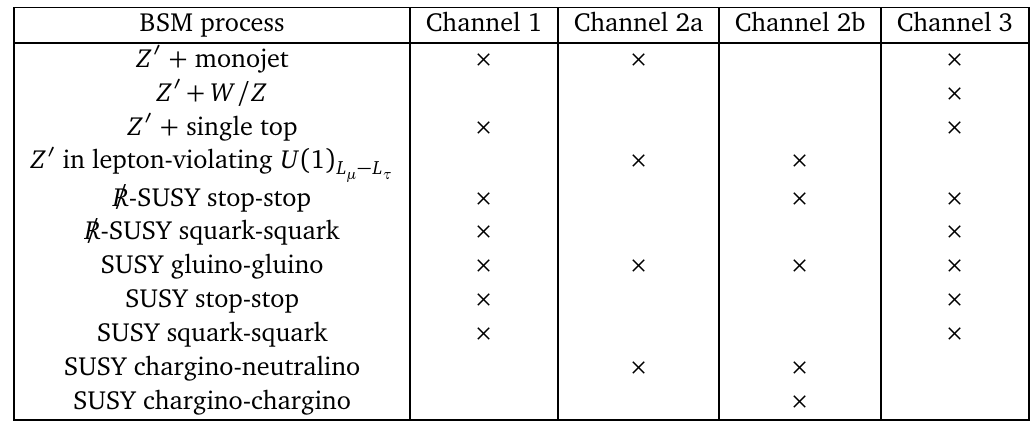
Table 3: BSM processes in each channel. More information on the masses of the specific processes can be found in the main text.